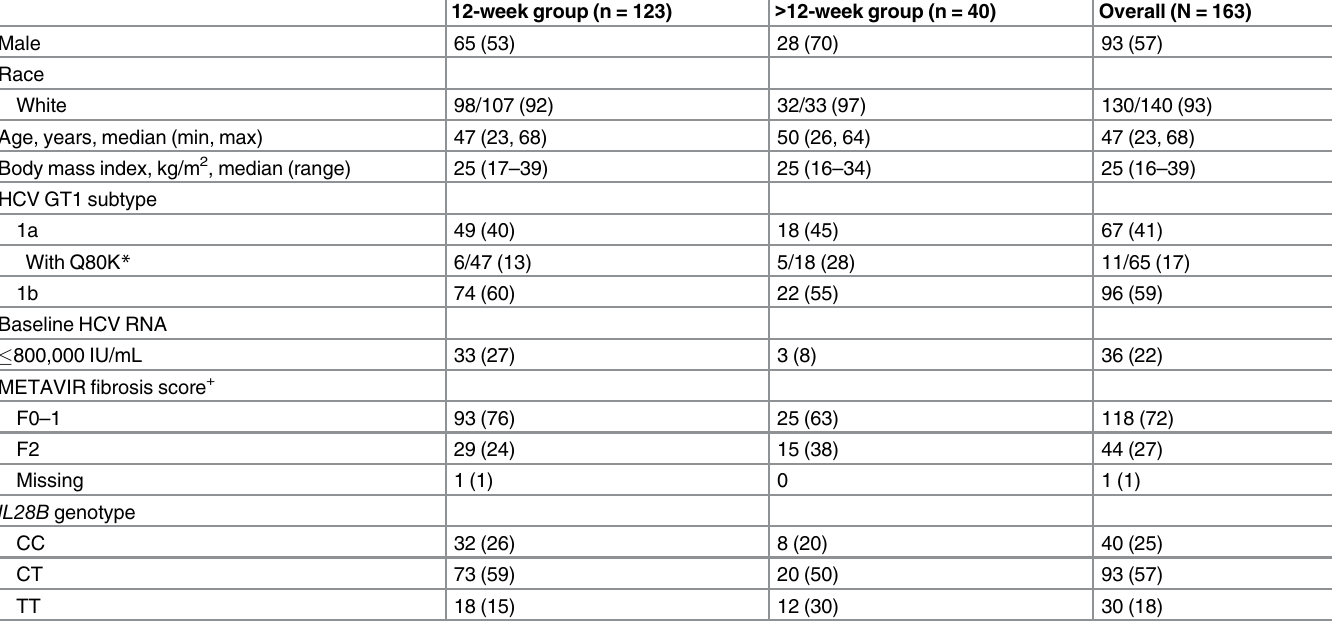
Table 1. Patient baseline demographics and disease characteristics. Data are n (%) unless otherwise stated. HCV GT1 subtype (Coalesce) is based on the NS5B assay, and if not available on LIPA HCV II or Trugene